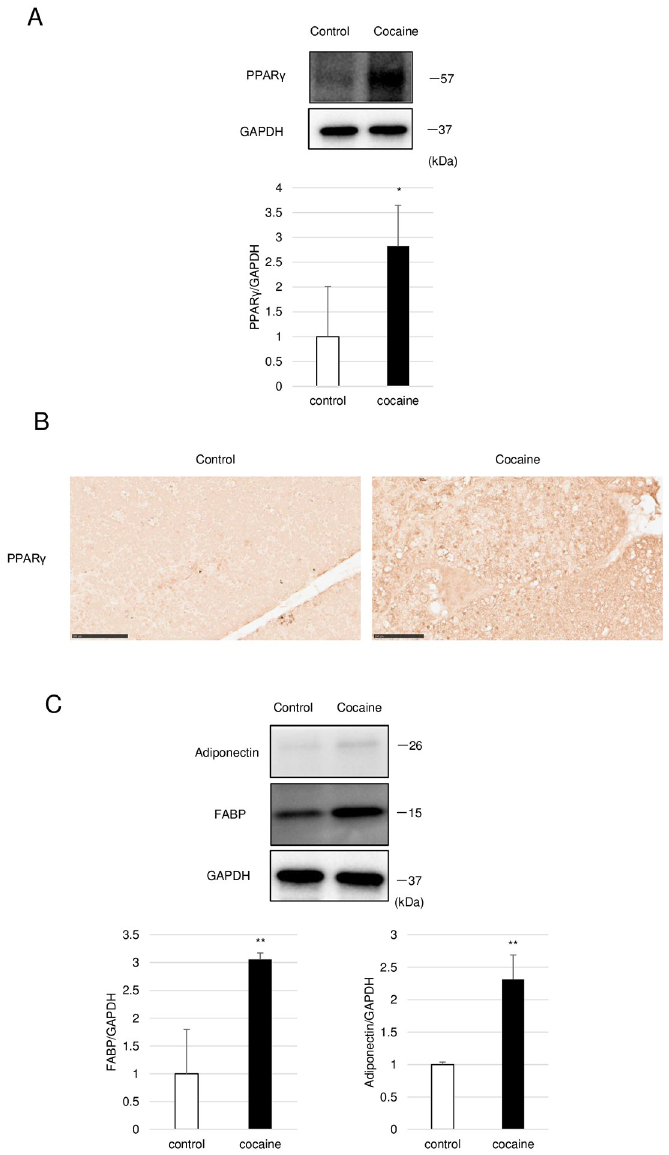
Fig 7. Increased levels of PPAR γ as well as adiponectin in thymus from rats administered cocaine for 14 days. Rats were treated with or without cocaine (20 mg/kg/day, 14 days). (A) Immunoblot analysis of PPAR γ in the thymus. GAPDH levels served as an internal control. (B) Immunohistochemical analysis of PPAR γ in the thymus. Arrowheads indicate nuclear localization of PPAR γ . (C) Immunoblot analysis of adiponectin and FABP in the thymus. GAPDH levels served as an internal control. Graphs show mean and S.E. � P < 0. 05, �� P < 0. 01 versus